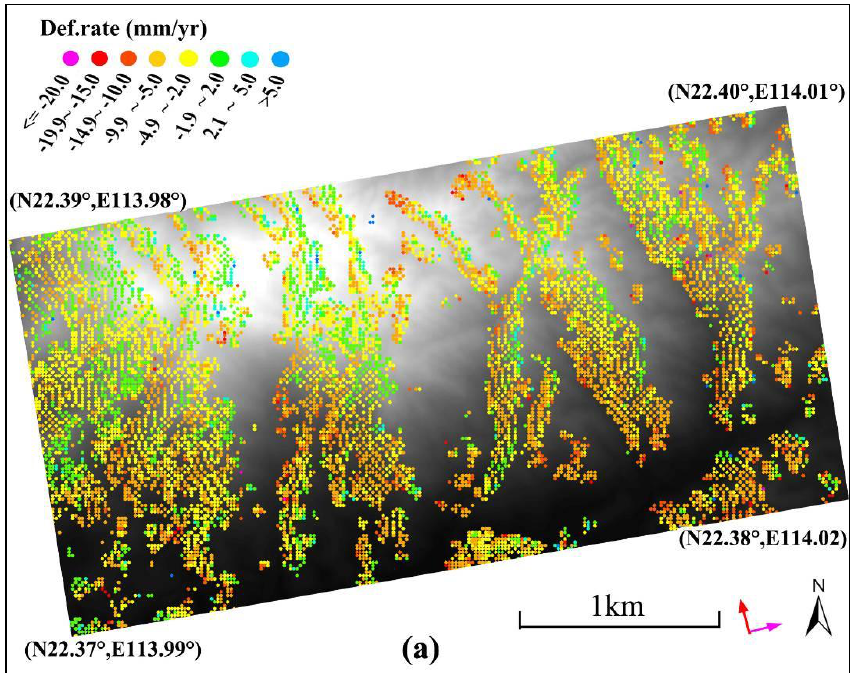
Figure 7. SB-InSAR derived LOS surface annual motion rates over Tai Lam region, the red and pink arrows indicate the satellite flight path and looking direction of line of sight, respectively. ( a ) PALSAR for the observation period from June 2007 to January 2011; ( b ) TerraSAR-X for the observation period from October 2008 to December